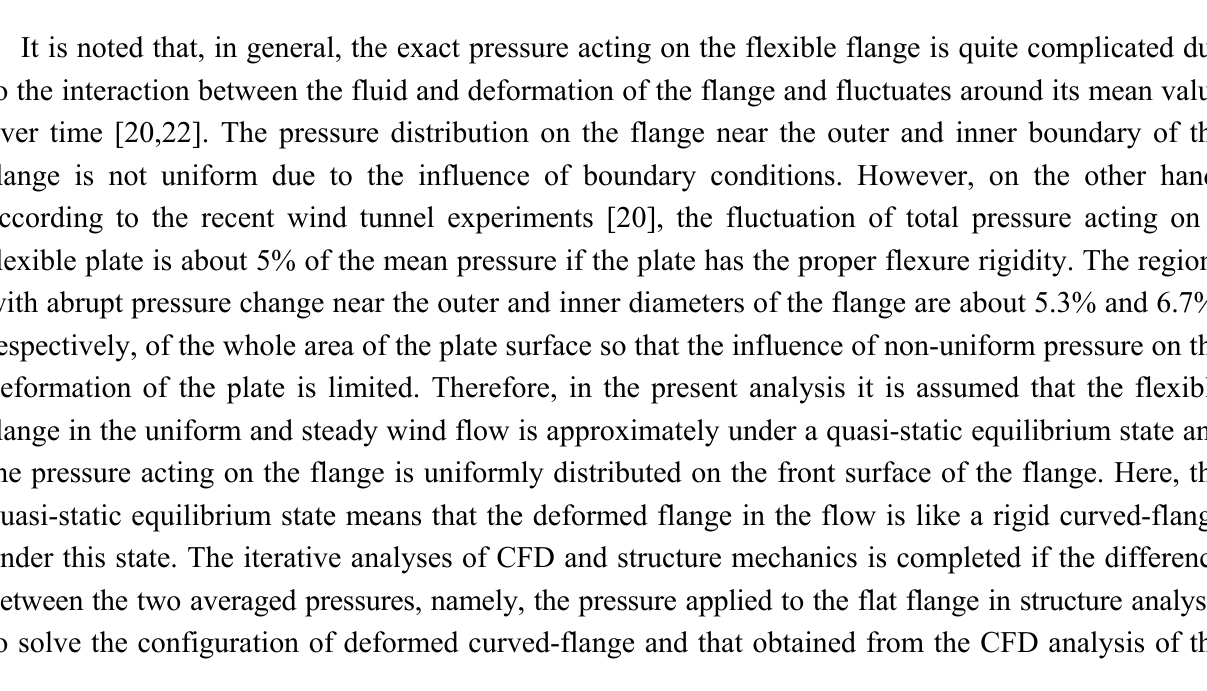
Figure 6. Flowchart of the iterative CFD and structure coupling